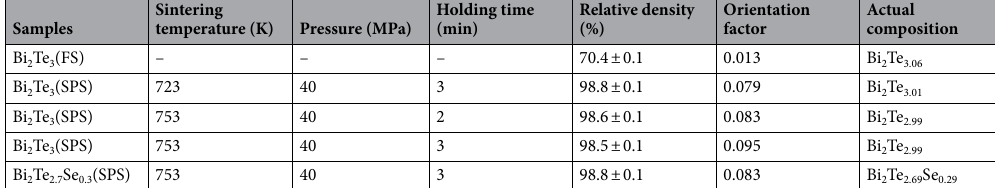
Table 1. Relative densities, orientation factors and compositions of the Bi 2 Te 3 compound synthesized by FS and the Bi 2 Te 3−x Se x bulk samples further prepared by SPS on different